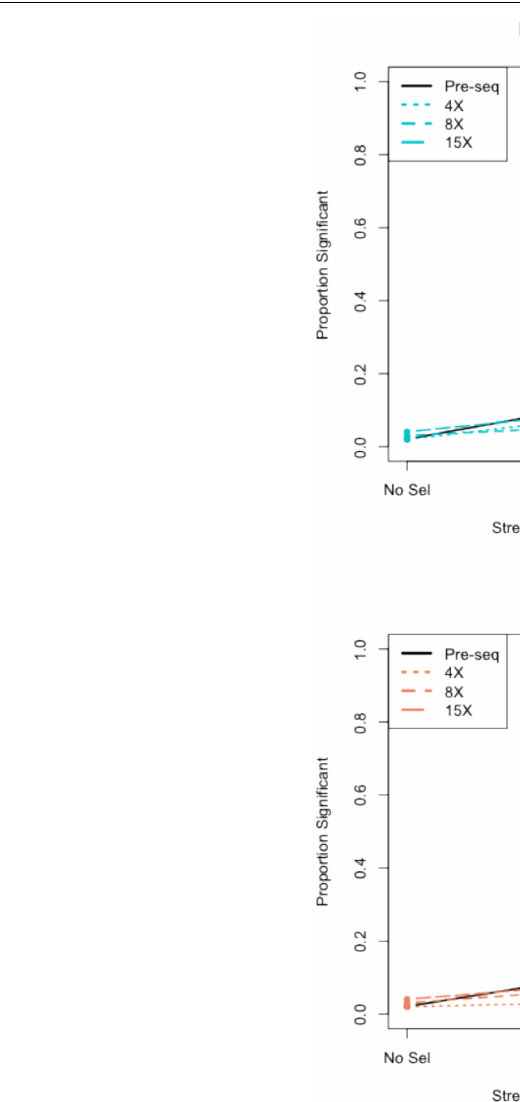
considered significant at 0.05 cutoff.The top panel shows the results for recent selective sweep models ( τ = 0.005) and the bottom panel shows results for models with relatively older selective sweeps ( τ = 0.01). “Pre-seq” refers to the complete sequence information, without simulated next-generation sequencing and SNP